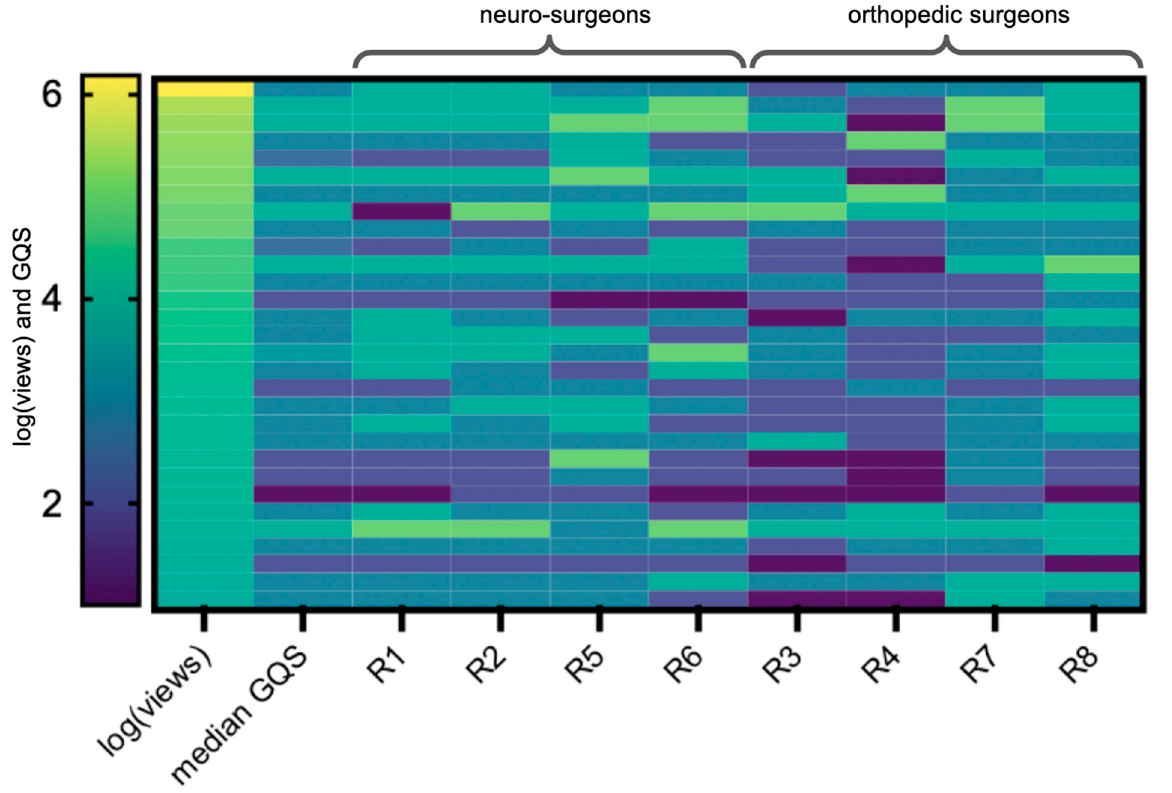
Figure 2. GQS scores for each video (rows) from all raters (column 3 to 10) and their median (column 2) were ordered by the logarithm of the respective views of each video (column 1). The darker the color, the fewer views and the worse the rating.